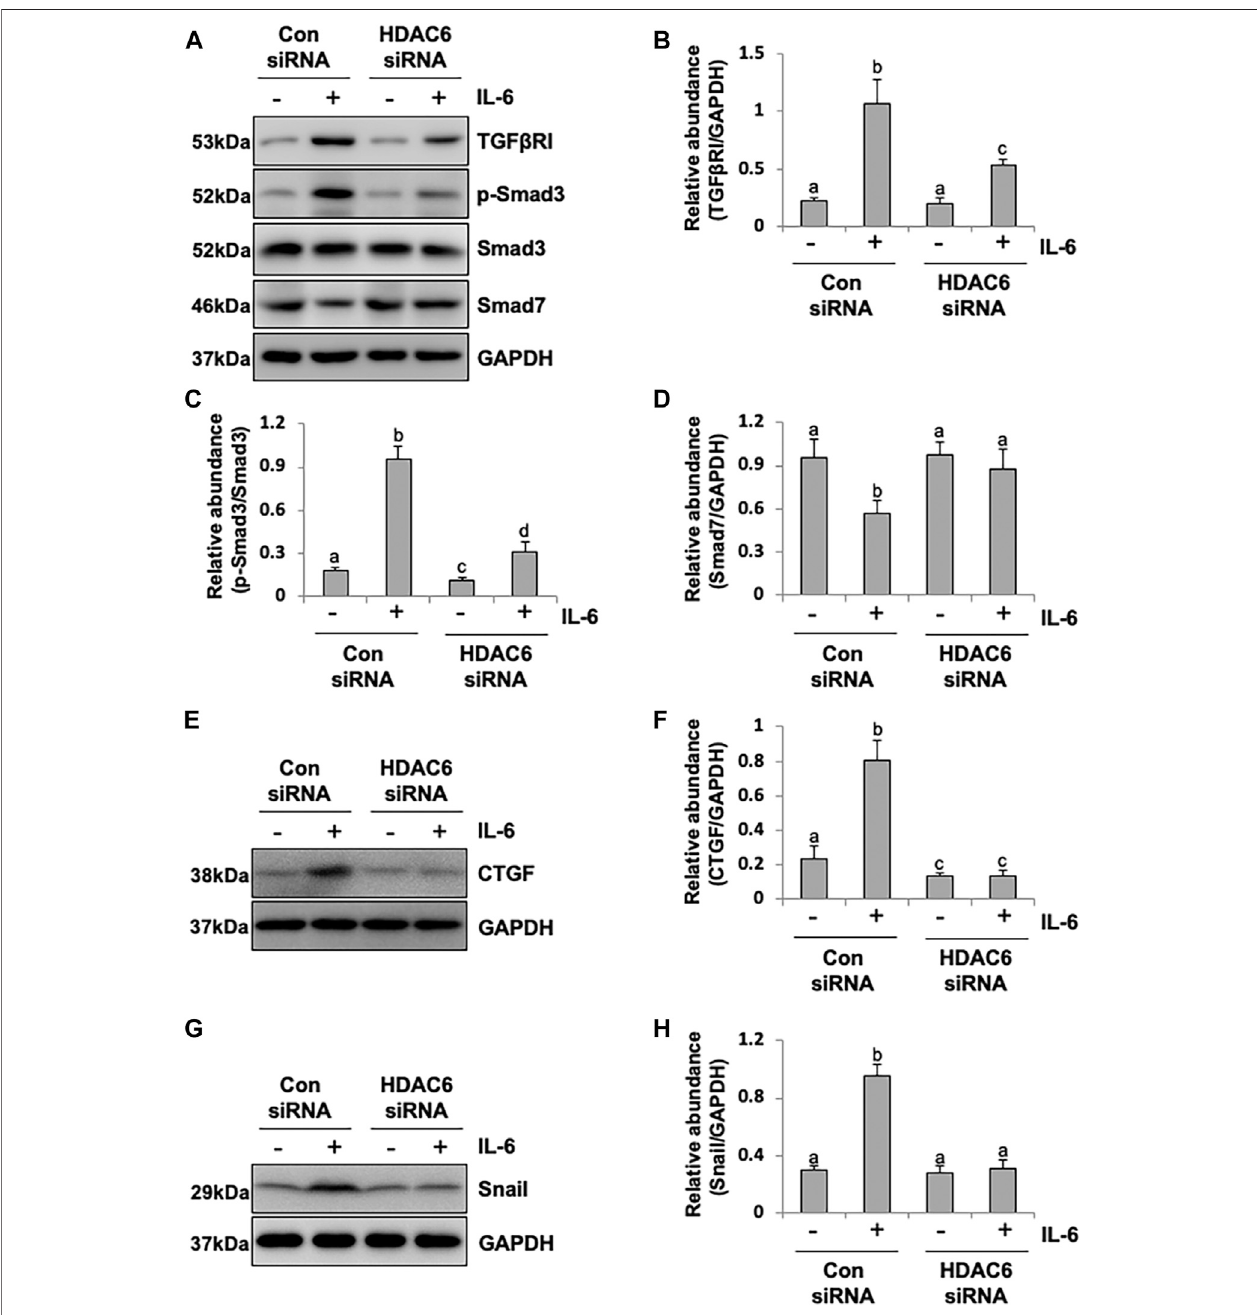
FIGURE 5 | siRNA-medicated silencing of HDAC6 inhibits the activation of the TGF- β signaling pathway and decreases the expression of CTGF and Snail in peritonealmesothelialcells. (A) Celllysatesweresubjectedtoimmunoblotanalysiswithspeci fi cantibodiesagainstTGF β RI,p-Smad3,Smad3,Smad7,andGAPDH. (B) Expression level of TGF β RI was quanti fi ed by densitometry and normalized with GAPDH. (C) Expression level of p-Smad3 was quanti fi ed by densitometry and normalizedwithSmad3. (D) ExpressionlevelofSmad7wasquanti fi edbydensitometryandnormalizedwithGAPDH. (E) Celllysatesweresubjectedtoimmunoblot analysis with speci fi c antibodies against CTGF and GAPDH. (F) Expression level of CTGF was quanti fi ed by densitometry and normalized with GAPDH. (G) Cell lysates were subjected to immunoblot analysis with speci fi c antibodies against Snail and GAPDH. (H) Expression level of Snail was quanti fi ed by densitometry and normalized with GAPDH. Data are represented as the mean ± SEM (n (cid:1) 3). Means with different superscript letters are signi fi cantly different from one another ( p < 0.05).